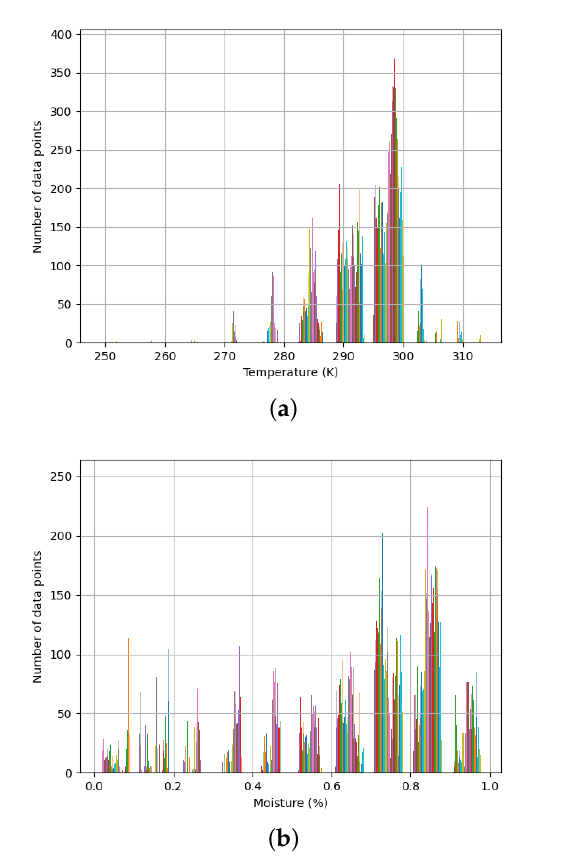
Figure 10. Model data distribution of LVT ( a ) and LVM ( b ) at the